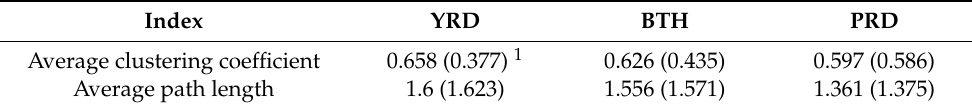
Table 3. Small-world of check flow network of three major urban agglomerations. Table 4. Community statistics of three major urban agglomerations.